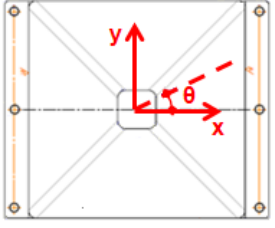
Figure 6. Reference system of the DCS.